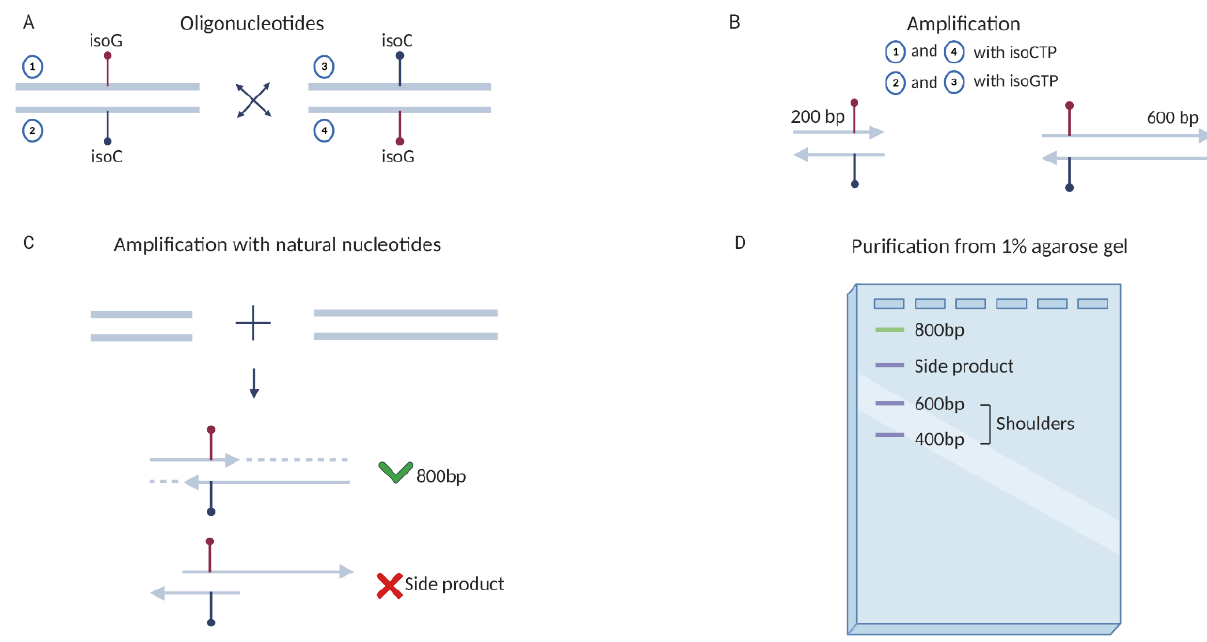
Figure 4. Scheme of the approach used to produce templates containing unnatural nucleotides isodG and 5-Me-isodC. ( A ) Pairs of primers complementary to each other, so that the forward primer carried 5-Me-isodC in the second position of the V29 codon, and the reverse primer carried isodG, and vice versa. ( B ) In the first round of PCR, two fragments were amplified using primers flanking both ends of the template and mutant primers carrying unnatural nucleotides. ( C ) In the second round of amplification, these PCR products were mixed without adding primers flanking ends of the template and performed 10 amplification cycles without using unnatural nucleoside triphosphates. ( D ) Single-stranded DNA molecules and unreacted fragments remaining in the reaction were removed by agarose gel electrophoresis.